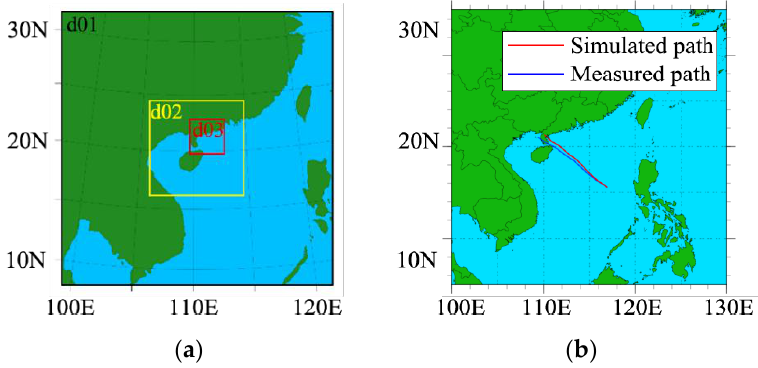
Figure 3. Schematic diagram of WRF simulation. ( a ) Simulation domain. ( b ) Typhoon track.